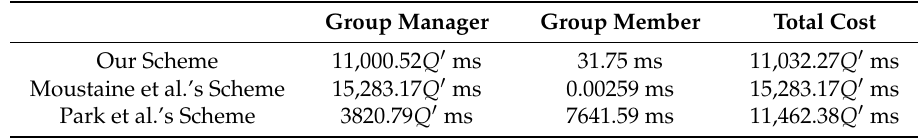
Table 4. The cost comparison of a Q (cid:48) + 1 users ( Q (cid:48) + 1 ) situation between [3,4] and our